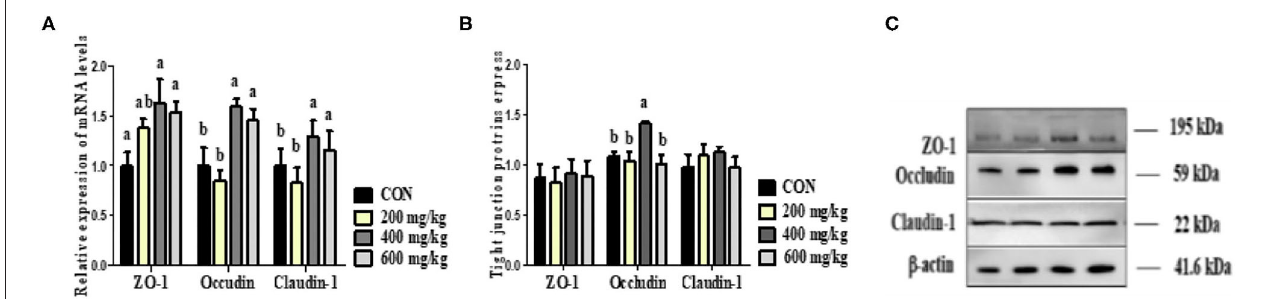
FIGURE 3 | Effects of dietary bacteriophage supplementation on the relative mRNA expression ( A , n = 5) and relative protein expression of tight junction proteins ( B,C , n = 5) in jejunum of weaned piglets fed antibiotic-free diet. Con: the control diet supplemented with 25 mg/kg quinocetone and 11.25 mg/kg chlortetracycline in the basal diet; Treatments (200, 400, and 600 mg/kg): the treatment diets supplemented with 200, 400, or 600 mg/kg bacteriophage in the basal diet; a,b Different letters above bars indicates significant differences ( P < 0.05).